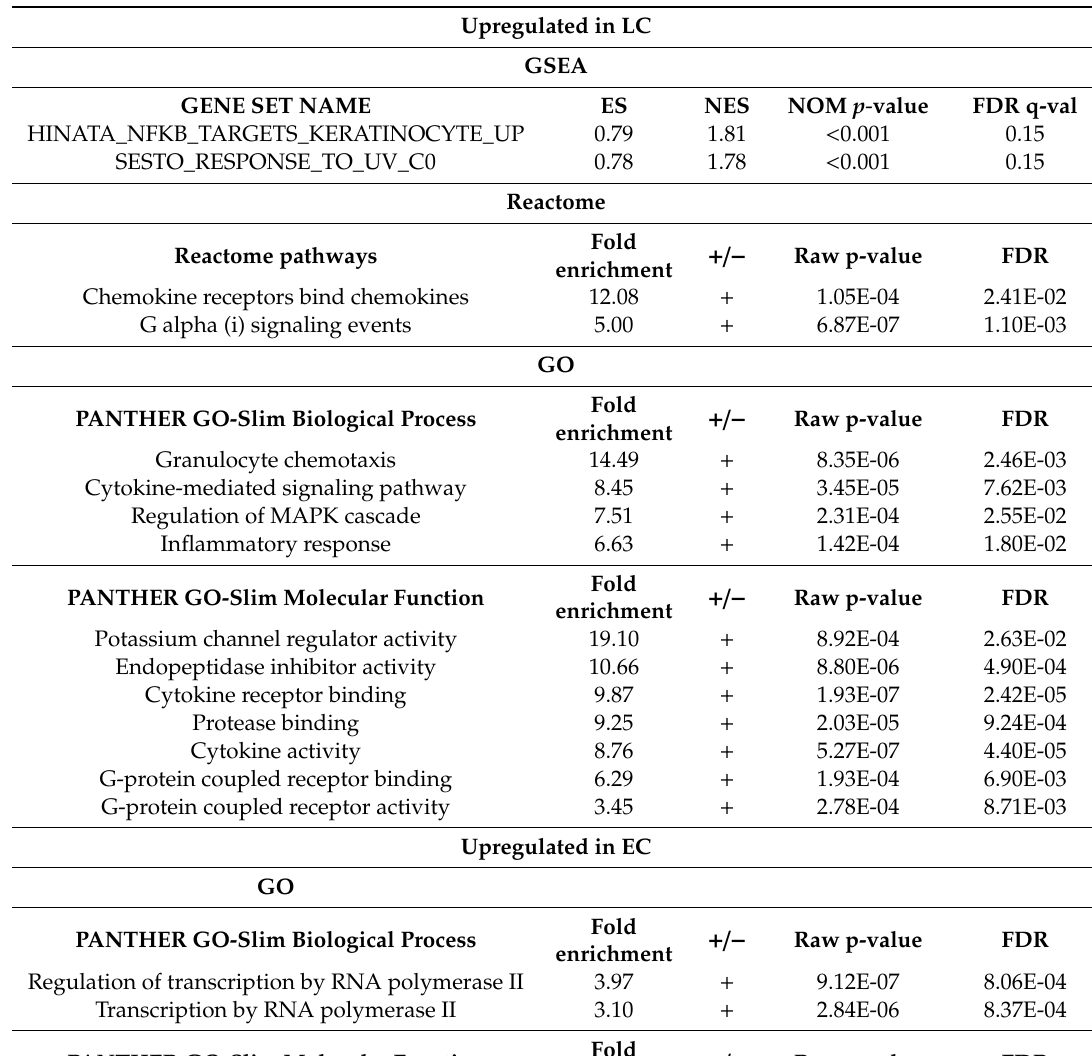
Table 1. Gene sets, reactome and GO terms enriched in late-stage (LC) and early-stage EC) CAFs. ES, enrichment score; NES, normalized enrichment score; NOM, nominal; FDR, false discovery rate. +/ − indicates enrichment or depletion of a given